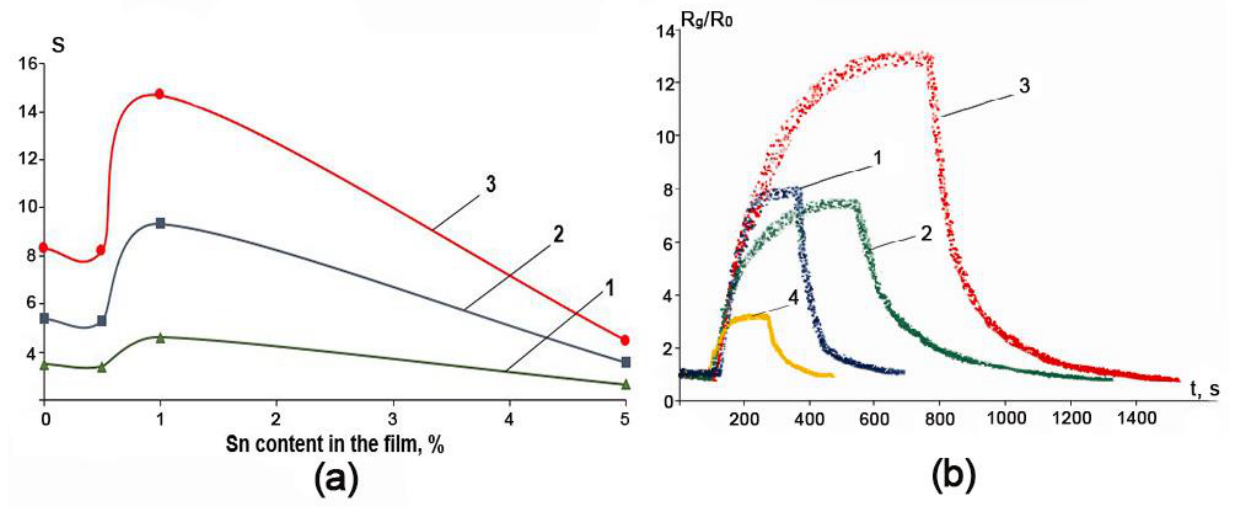
Figure 11. The dependence of the gas response of ZnO-SnO 2 films with various Sn content to NO 2 at concentrations of 5 ppm (1), 10 ppm (2), and 50 ppm (3) ( a ) and the typical R(t) response of ZnO-SnO 2 films: ZnO (1), Sn:Zn = 0.5:99.5 (2), Sn:Zn = 1:99 (3), Sn:Zn = 5:95 (4) when exposed to the 50 ppm of NO 2 at an operating temperature of 200 °C ( b ).